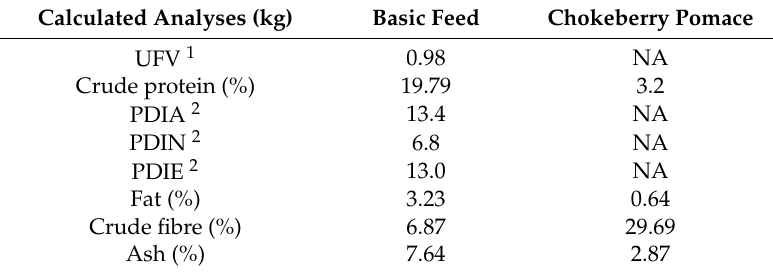
Table 8. Analytical composition of applied feed.